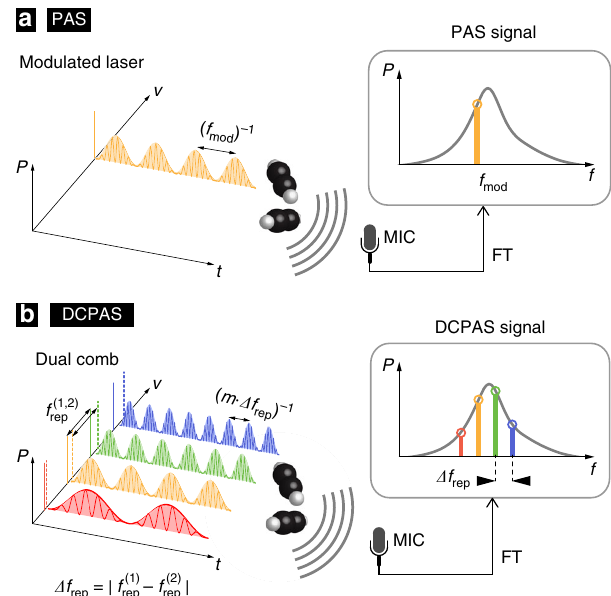
Fig. 1 Dual-frequency comb photo-acoustic spectroscopy. a In photo- acoustic spectroscopy (PAS), absorption of a modulated laser results in acoustic waves that are recorded by a microphone (MIC). The acoustic spectrum (after Fourier transformation, FT) contains the PAS signal tone at the modulation frequency f mod that indicates the strength of the optical absorption. b Dual-frequency comb photo-acoustic spectroscopy (DCPAS) uses broadband dual-frequency combs, whose repetition rates f ð 1 Þ differ by a small amount Δ f rep . The DCPAS signal is comprised of multiple heterodyne acoustic tones that simultaneously sample the optical absorption spectrum at multiple optical frequencies. ( P : power; ν and f : optical and acoustic frequencies; t :